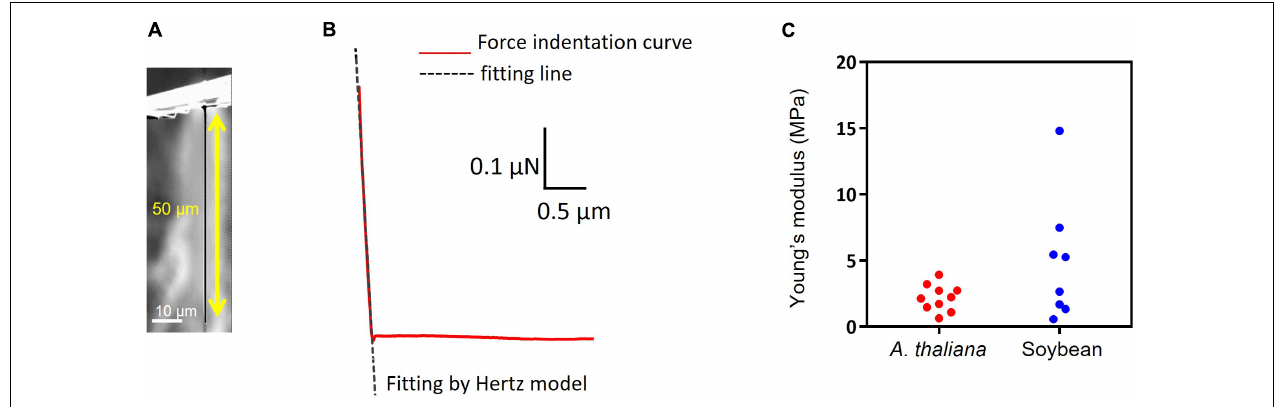
FIGURE 2 | Stiffness measurement and insertion efficiency result. (A) Image of pillar indenter. (B) An example force-indentation curve of pillar indenter. The dashed line shows fitting by the Hertzian model. (C) Young’s modulus results of Arabidopsis thaliana leaf and soybean SAM.